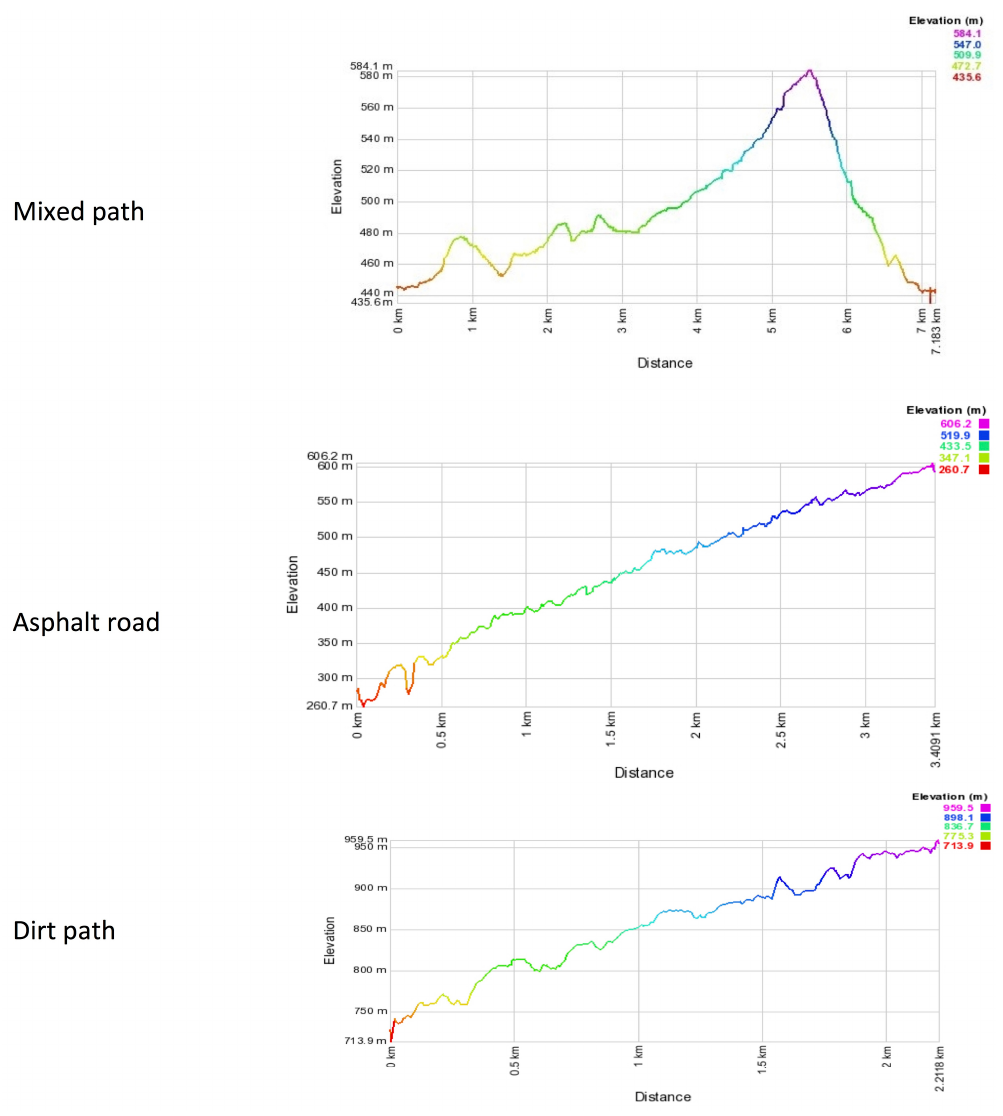
Figure 1. Elevation profiles of the three different experimental paths.